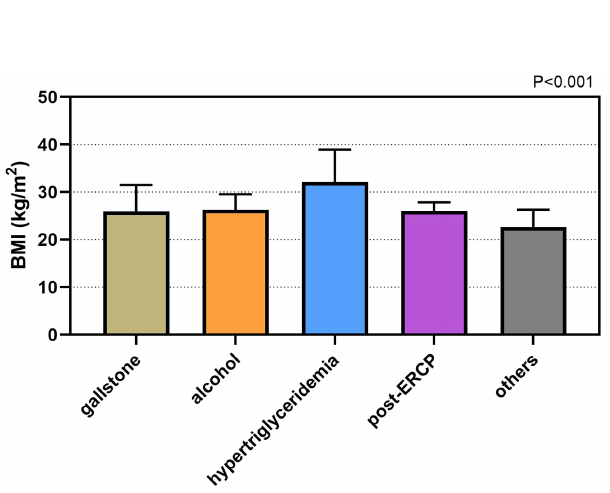
Figure 1. Values of BMI in different groups of AP etiology. The values of BMI in hyperlipidemic AP patients were statistically higher than those in other AP patients. BMI, body mass index; AP, acute